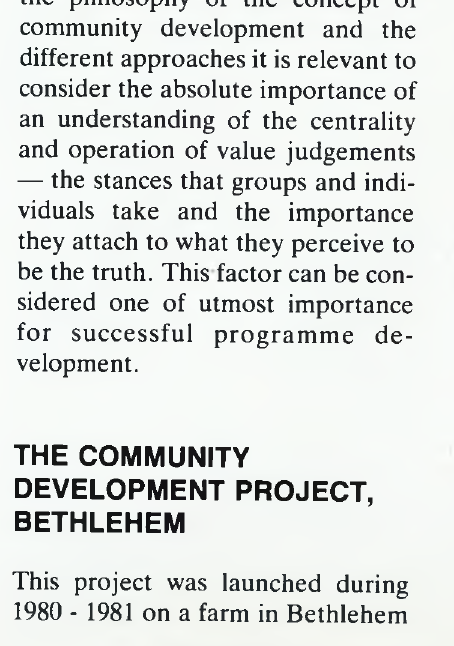
Figure 2 Phases of the community development process (Facilitated by the Community